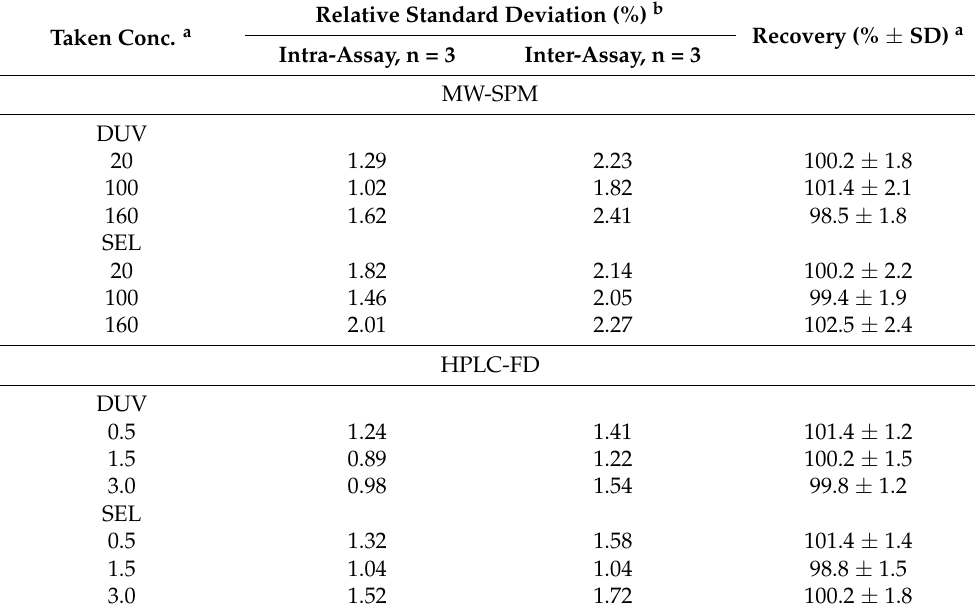
Table 4. Precision and accuracy of the proposed MW-SPM and HPLC-FD for determination of DUV and SEL. Taken Conc.